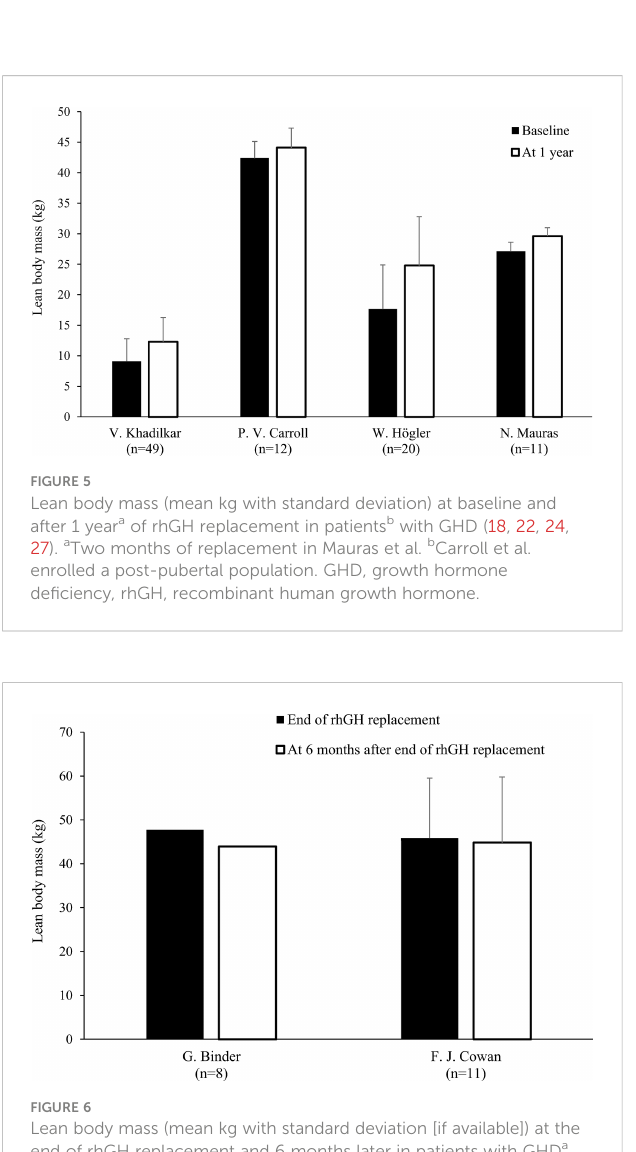
TABLE 3 Effects of rhGH therapy on lipid pro fi les and insulin metabolism in children with GHD (reported differences are intended as statistically signi fi cant). Study